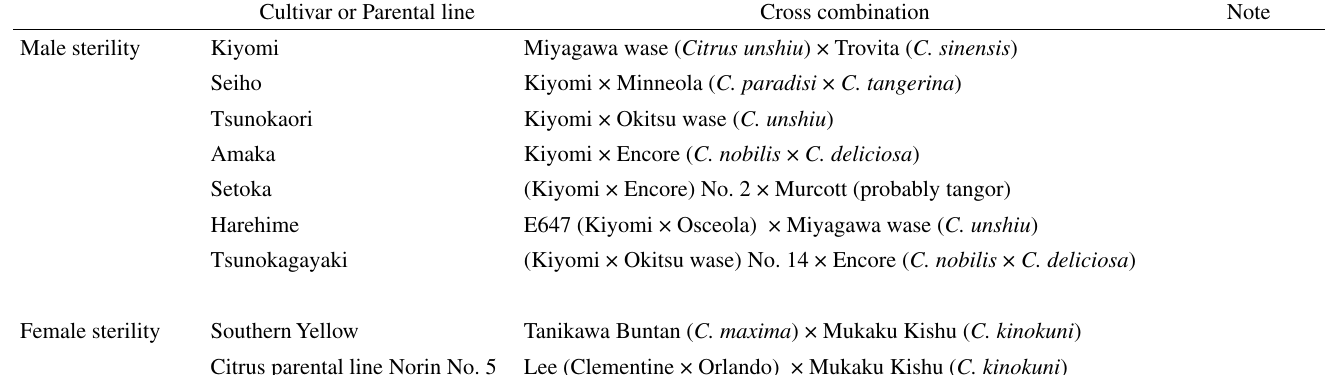
Table 2 - Seedless cultivars and parental lines of citrus released in Japan Cultivar or Parental line Cross combination